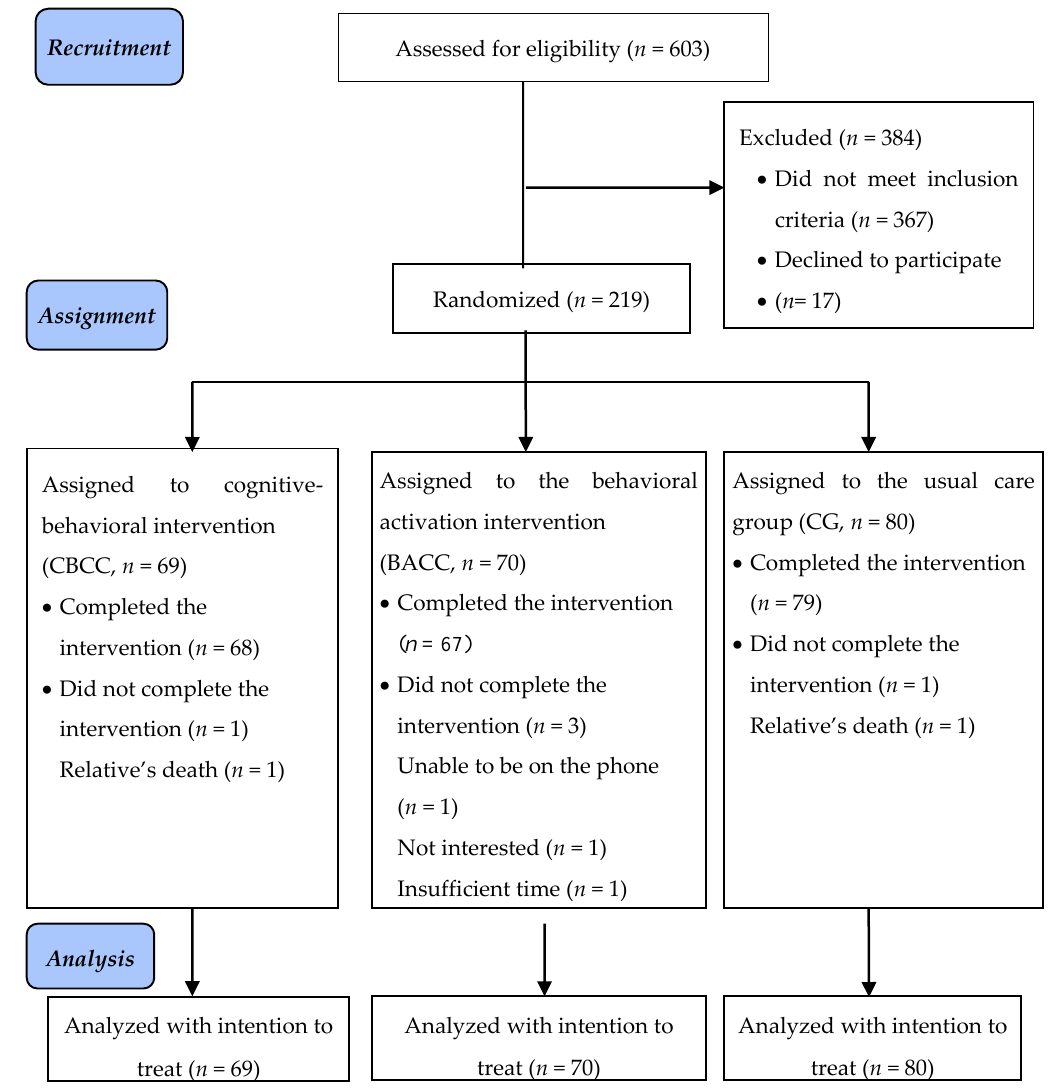
Figure 1. CONSORT 2010 Flowchart.